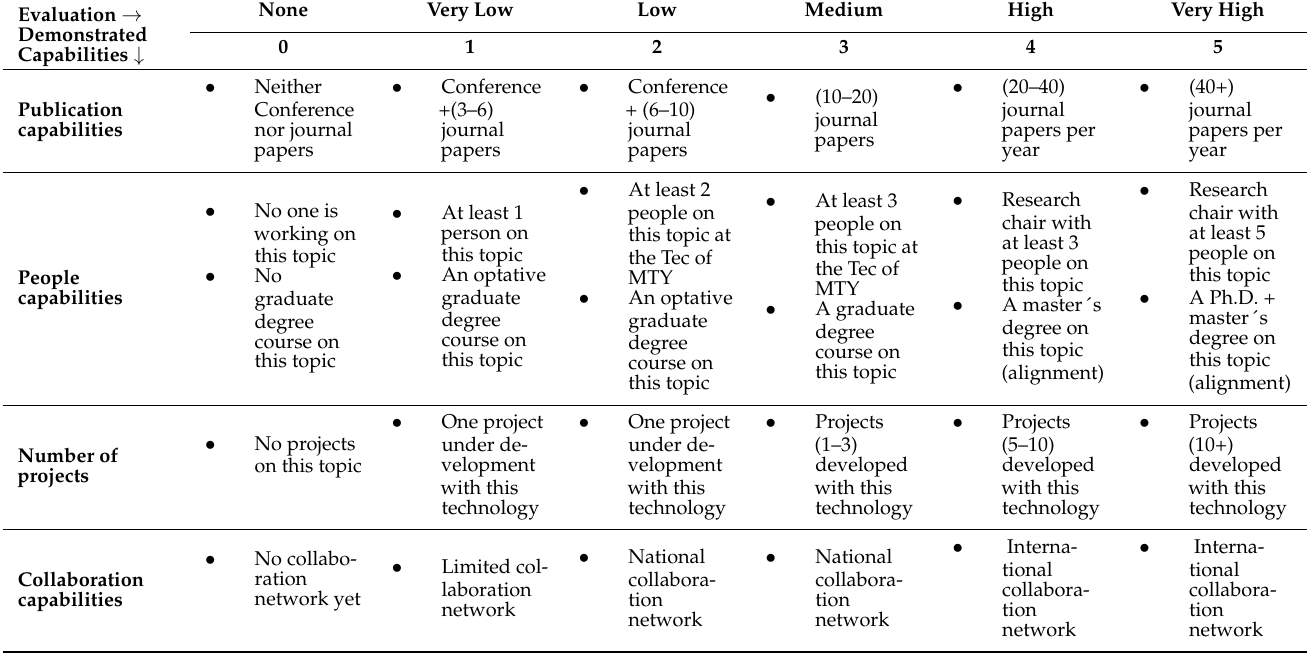
Table 4. Internal know-how